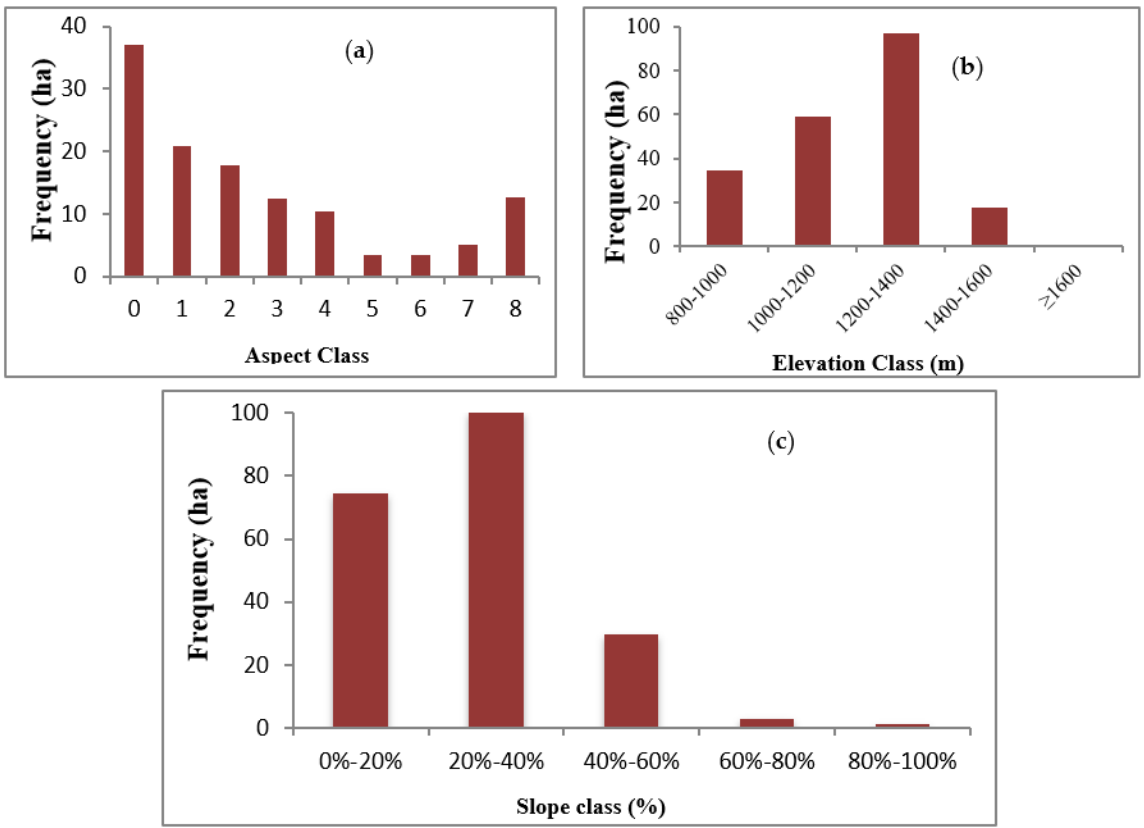
Figure 4. Class frequency of the abiotic factors, aspect ( a ), elevation ( b ), and slope ( c ), over the study area.